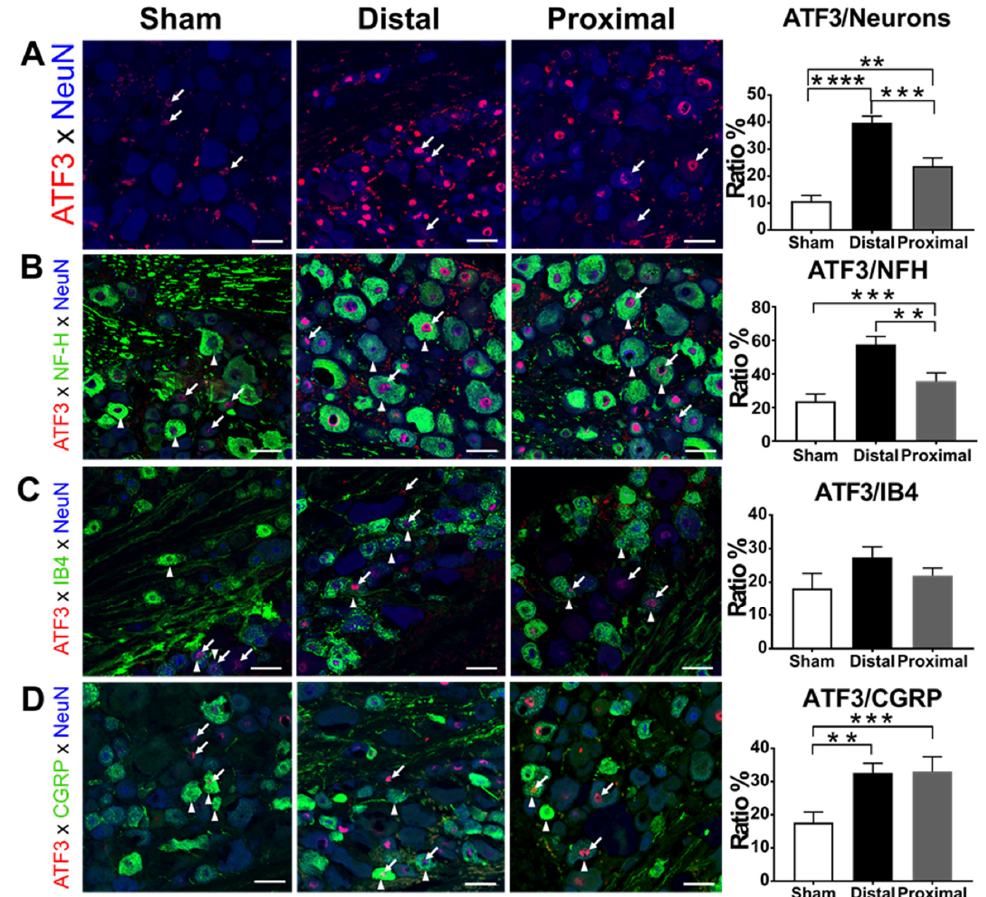
Figure 4. The characterization of ATF3-positive DRG neurons. The ratios of ( A ) total ATF3, ( B ) ATF3/NFH, ( C ) ATF3/IB4, or ( D ) ATF3/CGRP colocalized DRG neurons of animals with distal nerve constriction (Distal), proximal nerve constriction (Proximal), or sham operation (Sham). Data are mean ± SEM, N = 6 rats in each group. ** p < 0.01, *** p < 0.001, **** p < 0.0001, scale bar = 50 μ m. Arrows indicate the ATF3 expression, arrowheads indicate a neuron subtype marker (NFH, IB4, or CGRP).